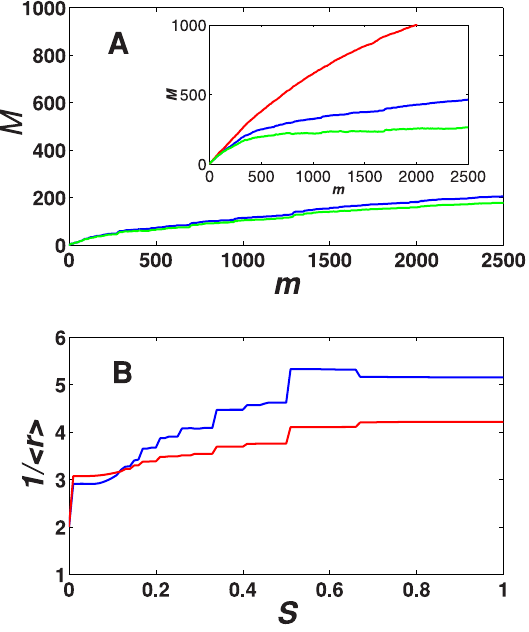
Figure 3. Comparison with MimMiner. (A) The inset figure shows the number ( M ) of weighted disease pairs with shared KEGG pathways that were ranked higher than m by MimMiner (in red) and or by our method (in blue). Also shown in the inset (in green) is the weighted number of pairs with common term associations missed (ranked lower) by MimMiner, but identified (ranked higher) by our model. In the main panel, the same quantities corresponding to the proposed method are plotted after exclusion of obvious candidates for being related. The closeness between the blue and green curves indicates that the non- apparent candidates found by our method are largely missed by MimMiner. Displayed in panel (B) is the inverse of average normalized rank versus the term similarity cutoff. At large similarity cutoff, the higher the average normalized rank (the smaller S r T and thus the larger 1 = S r T ) the better the agreement between the quality scores (cosine similarity or the MimMiner score) and the KEGG annotation.